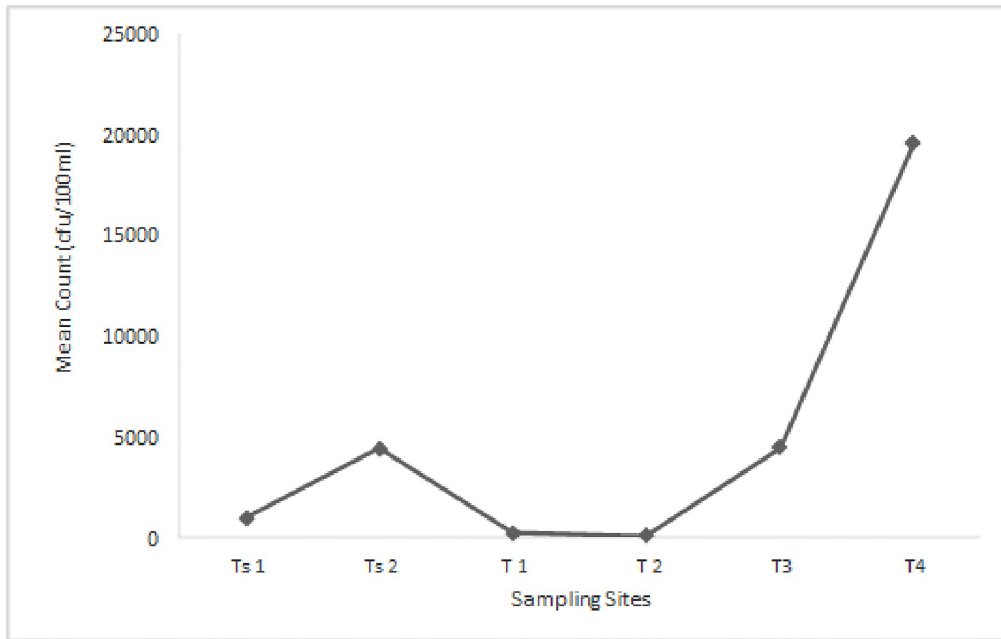
Fig 2. The mean of Enterobacteriaceae cell counts from Tsomo and Tyhume rivers. Ts1 and Ts2 are sampling points along the Tsomo river, while T1 –T4 are sampling points along the Tyhume river. Using the Welch and Brown-Forsythe robust tests of equality of means, the mean counts were statistically significant at P � 0.05 and F = 256.59. The statistics were asymptotically F distributed.